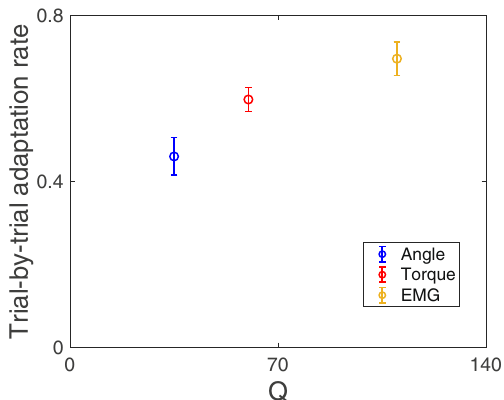
Figure 1. Conventional trial-by-trial adaptation rates increase with increased control noise. Publicly available data 25 from a movement task with three different controllers of different noise levels. Regression-based trial- by-trial adaptation rates increase with controllers that have increased control noise. Figure adapted from 11 to display absolute values of trial-by-trial adaptation rates and omit amputee participant data. In the originating study, the control noise parameter of a hierarchical Kalman filter model was tuned to fit experimental data to generate the estimates of control noise for each controller type presented on the x-axis 11